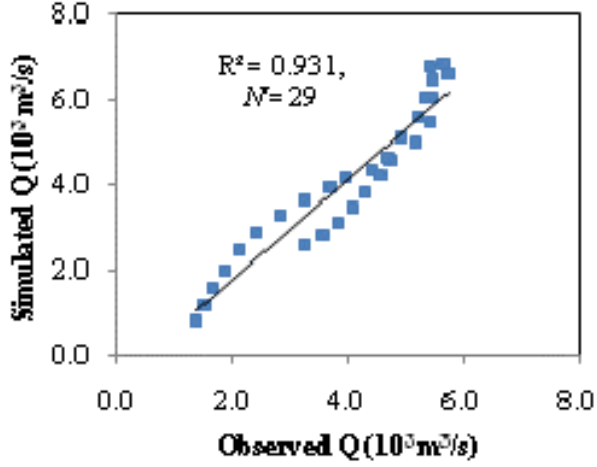
Fig. 10. Correlation of observed and simulated hourly water dis- charge at Tateyama (11 July 2002) ( N =number of observations).